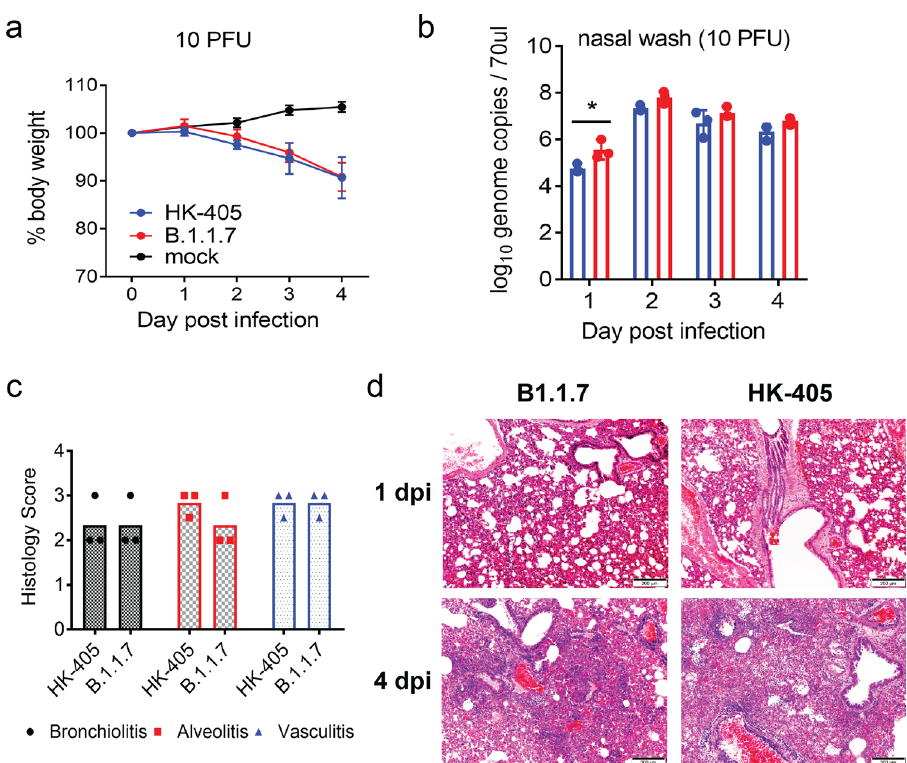
Fig. 4 Characterisation of hamsters infected with low dose inocula of B.1.1.7 and HK-405. a Body weight loss of hamsters infected with low dose inocula (10 PFU) of B.1.1.7 and HK-405. b Viral genome copies in nasal washes of the hamsters infected with B.1.1.7 and HK-405 collected on day 1 to 4 postinfection. Individual data points and mean ± SD are shown. c Histological score for lungs of infected hamsters on 4 dpi. d Representative images of H&E-stained hamster lung (left superior lobes) taken on 1 and 4 dpi. On 1 dpi, both viruses infected lung showed alveolar congestion. But on 4 dpi, diffuse alveolar in fi ltration, exudation and localized haemorrhage were observed after both viruses infection. Bronchiolar luminal cell debris (solid arrows) and vascular in fi ltration (open arrows) were also observed. Scale bars = 200 µ reaction (PCR), as described in the ARTIC network (https://artic.network/ncov- batch of aliquots and used without freeze-thawing. Viral RNAs were obtained from 2019). The PCR contained a pool of 98 primer pairs, which generated overlapping the supernatants of infected cells and then isolated using the QIAamp RNA Viral 400-bp amplicons across the entire genome of SARS-CoV-2 (accession no: kit (Qiagen) and subjected to whole viral genome sequencing. NC_045512) (primer sequences are shown in Supplementary Table 1). The fi nal Whole viral genome sequencing . Viral RNA was extracted from the supernatant of the infected Vero E6 cells using the QIAamp RNA Viral kit (Qiagen). 140ul of the sample was treated with 560 µl of AVL, containing carrier RNA, and then mixed with 560 µl of absolute ethanol. The sample was then transferred into QiaAmp spin column, centrifuged, washed with wash buffer provided and then eluted with 20 ul of DEPC-treated water. Viral RNA was then treated using the TURBO DNA-free Kit (ThermoFisher Scienti fi c) to remove residual host DNA, Indexed Adapter Kit (Roche Applied Science) according to the manufacturer ’ s and then reverse-transcribed using SuperScript IV reverse transcriptase (Invitro- instructions. Ligated libraries were then enriched by six-cycle PCR ampli fi cation, gen). The viral cDNA was then enriched through multiplex tiling polymerase chain